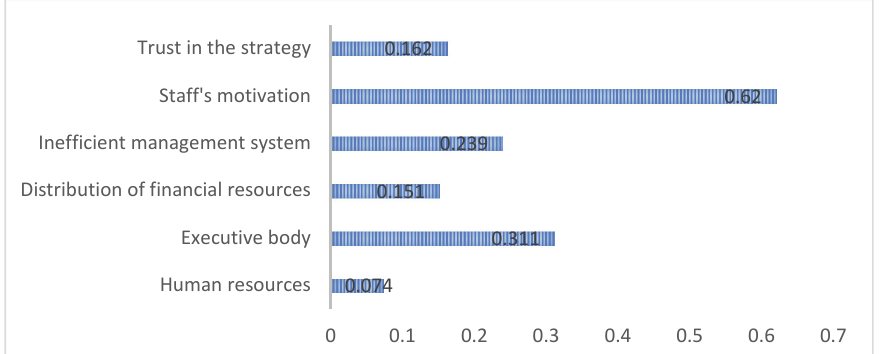
Fig. 3. The results of the implementation of AHP method for ranking behavioral